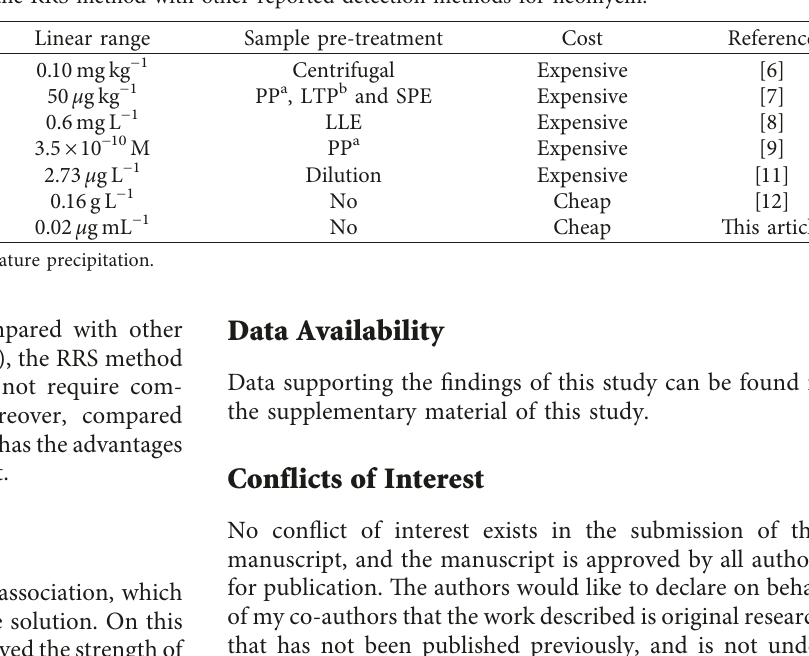
Table 4: Comparison of the RRS method with other reported detection methods for